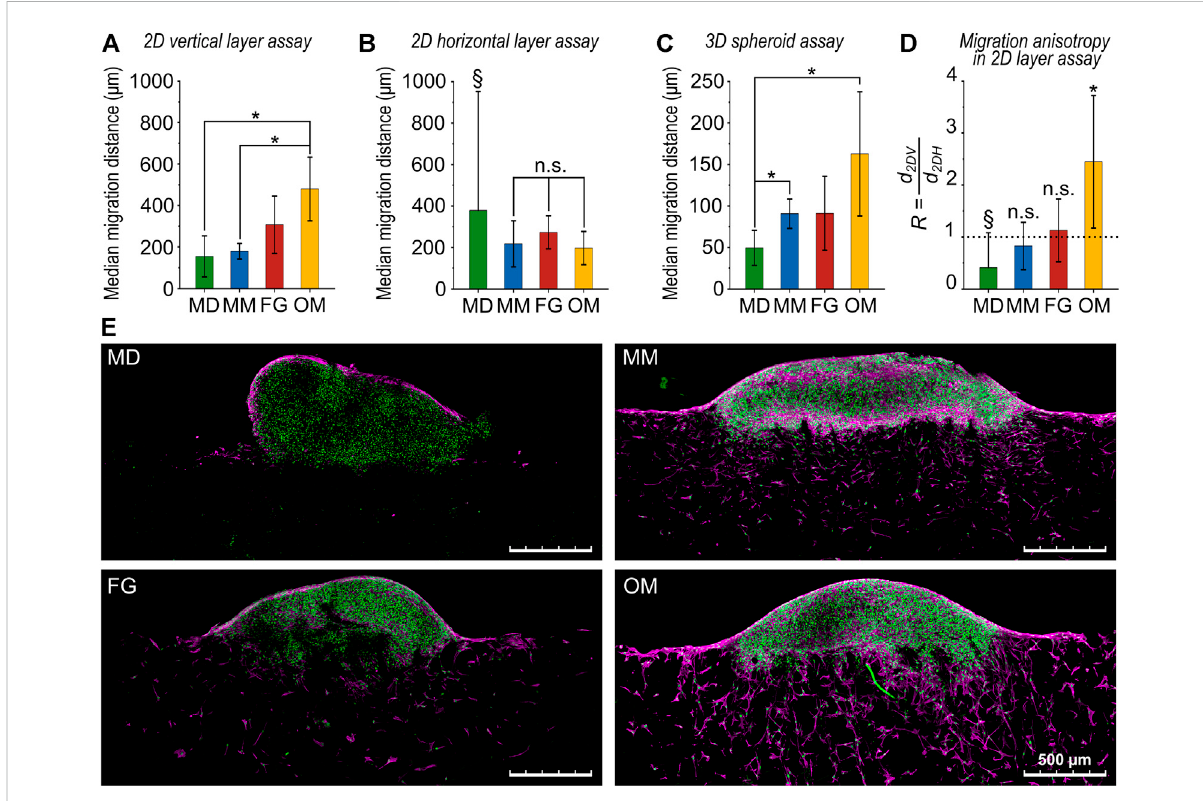
FIGURE 4 Comparison of cellular migration distances for the investigated biomaterials. (A) Migration distance obtained from the 2D vertical layer assay ( d 2DV ), (B) the 2D horizontal layer assay ( d 2DH ), and (C) the 3D spheroid assay ( d 3D ). All results are given as mean values of the median migration distance ±standard deviation; (D) ratio R between 2D vertical and horizontal migration distances. The dotted line highlights the value of R = 1 indicating isotropic migration behavior. In (A and C) , all comparisons between groups that are not indicated as statistically signi fi cant (*) were not statistically signi fi cant (n.s.). In (D) , statistical signi fi cance was tested between d 2DV and d 2DH for each biomaterial. Data marked with the§ symbol werenotstatisticallytested(forexplanationseemaintext); (E) representativeimages(maximumprojections)ofthe3Dspheroidassay.Cellnucleiare in green and F-actin in magenta. Scale bars are 500